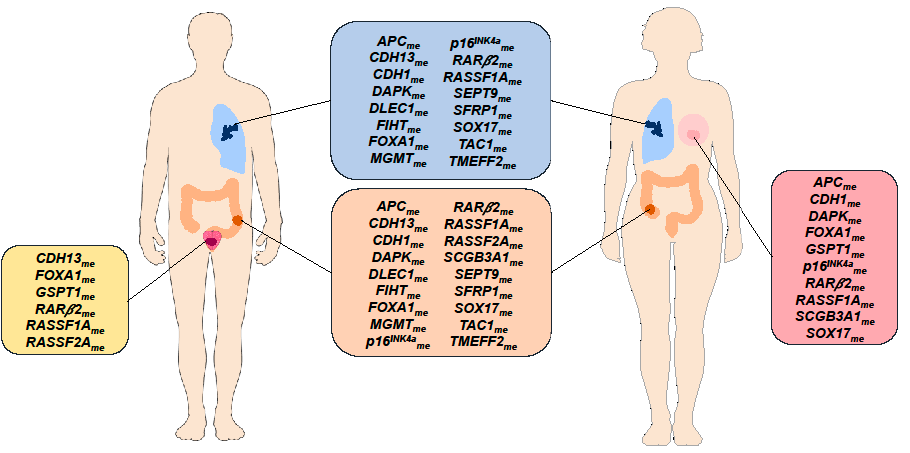
Figure 5. Circulating cell-free DNA methylation-based biomarkers described in the literature for cancer detection common to at least two cancer types [Breast Cancer (pink box), Lung Cancer (blue box), Prostate Cancer (yellow box), Colorectal Cancer (orange box)].